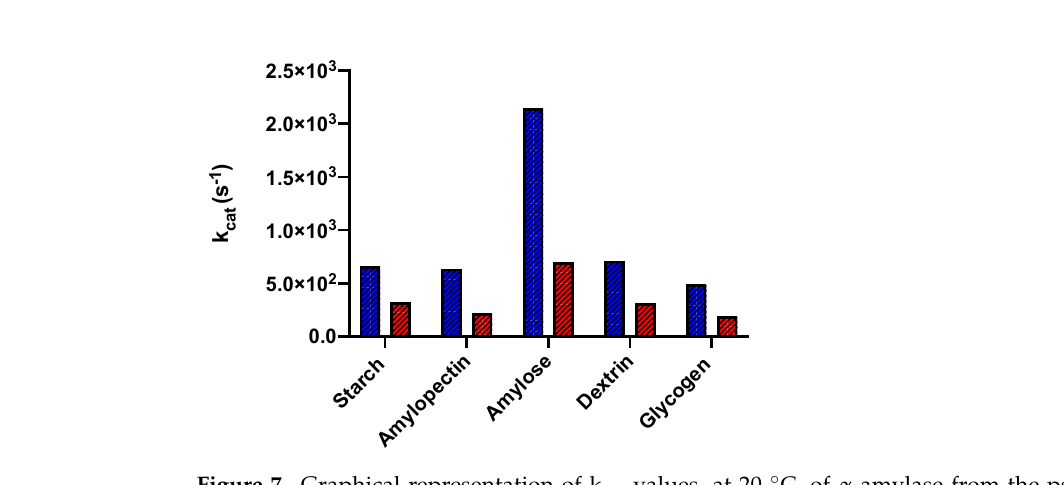
Figure 7. Graphical representation of k cat values, at 20 °C, of α-amylase from the psychrophile P. haloplanktis (in blue) and from the mesophile S. scrofa (in red) on different substrates.